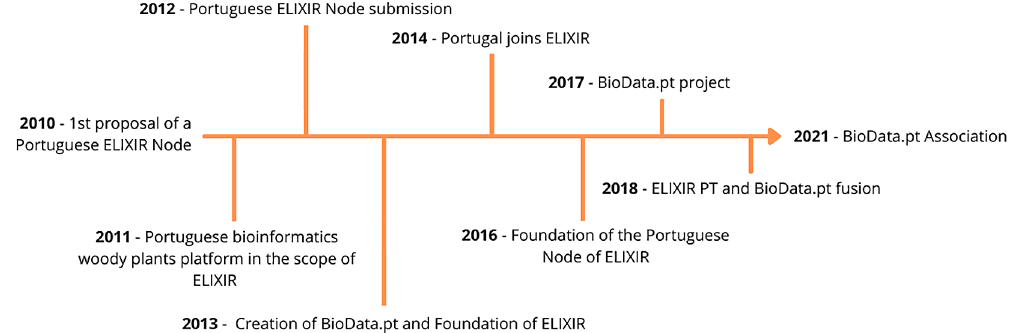
Figure 1. Historical path of the Portuguese Node of ELIXIR. In 2010, a Portuguese researcher from IGC (Instituto Gulbenkian de Ciência) at the European Bioinformatics Institute was challenged to participate in the onset of ELIXIR and create the Portuguese Node of this, yet to be, research infrastructure. In 2011, a first step was done, by creating thePortuguesebioinformaticswoodyplantsplatformfollowedbythecreationofBioData.pt – PortugueseBiological Data Network, to operate the Portuguese Node of ELIXIR (ELIXIR PT), in 2013. In the same year, the ELIXIR, an intergovernmental organisation bringing together life science resources from across Europe, namely, databases, software tools, training materials, cloud storage and supercomputers, was founded. In 2014, the Fundação para a Ciência e a Tecnologia, on behalf of the Portuguese Government, signed the ELIXIR Consortium Agreement, by which Portugal adhered to ELIXIR and, in 2016, a collaboration agreement between INESC-ID (Instituto de Engen- haria de Sistemas e Computadores, Investigação e Desenvolvimento) and ELIXIR was signed, creating the Portu- guese Node of this pan-European infrastructure. The merger between BioData.pt and ELIXIR PT was formalized in 2018 and, very recently, already in 2021, the BioData.pt Association was founded as the legal entity of this RI.